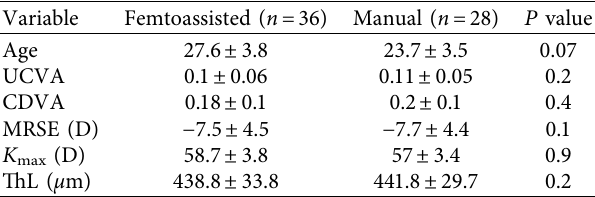
Table 1: Baseline characteristics of study